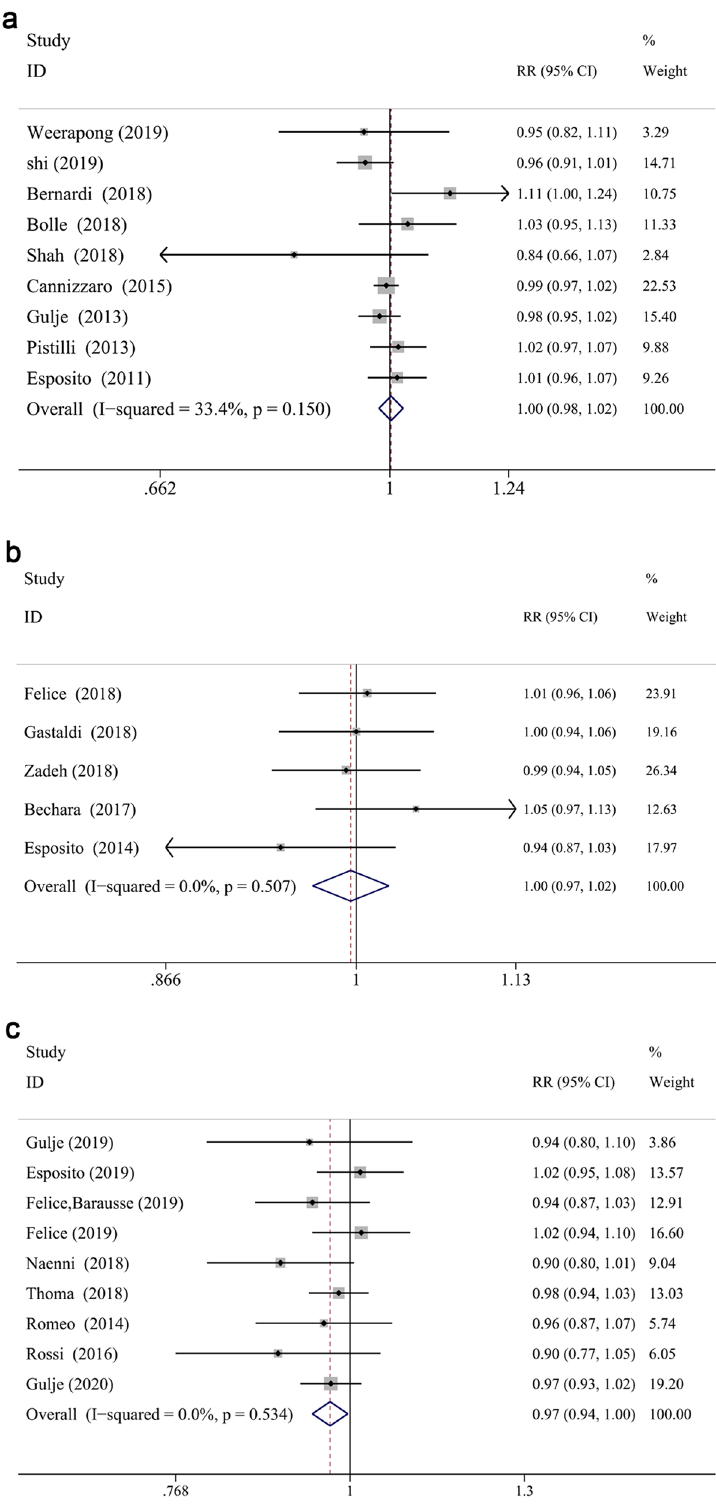
Figure 2. Forest plots (RR) of the survival rate comparing extra-short with longer implants group in 1-year ( a ), 3-years ( b ) and 5-years ( c ) results. Mantel–Haenszel (MH)- weighted RR < 1 indicated a lower survival rate of extra-short implants than the longer